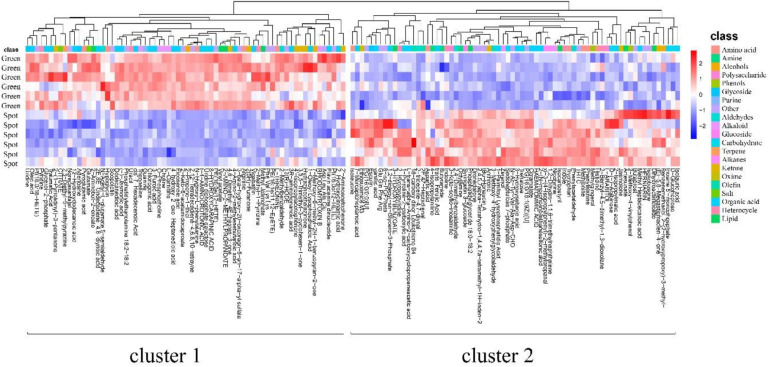
Metabolite patterns detected in two clusters. The abscissa represents the different experimental groups, the ordinate represents metabolites compared between the groups, and the colored blocks at different positions represent the relative expression of metabolites at those positions. The metabolites for which VIP > 1 and P < 0.05 were considered to be significantly changed.